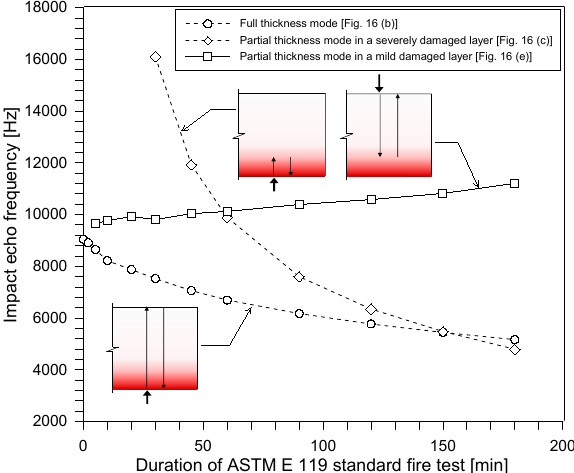
Figure 17. Acoustic impedance within fire-damaged concrete: ( a ) predicted acoustic impedance within fire-damaged concrete with increasing the time of fire exposure after the ASTM E 119 standard fire test, and ( b ) an example of determining the approximate depth of an acoustic reflector in fire- damaged concrete.